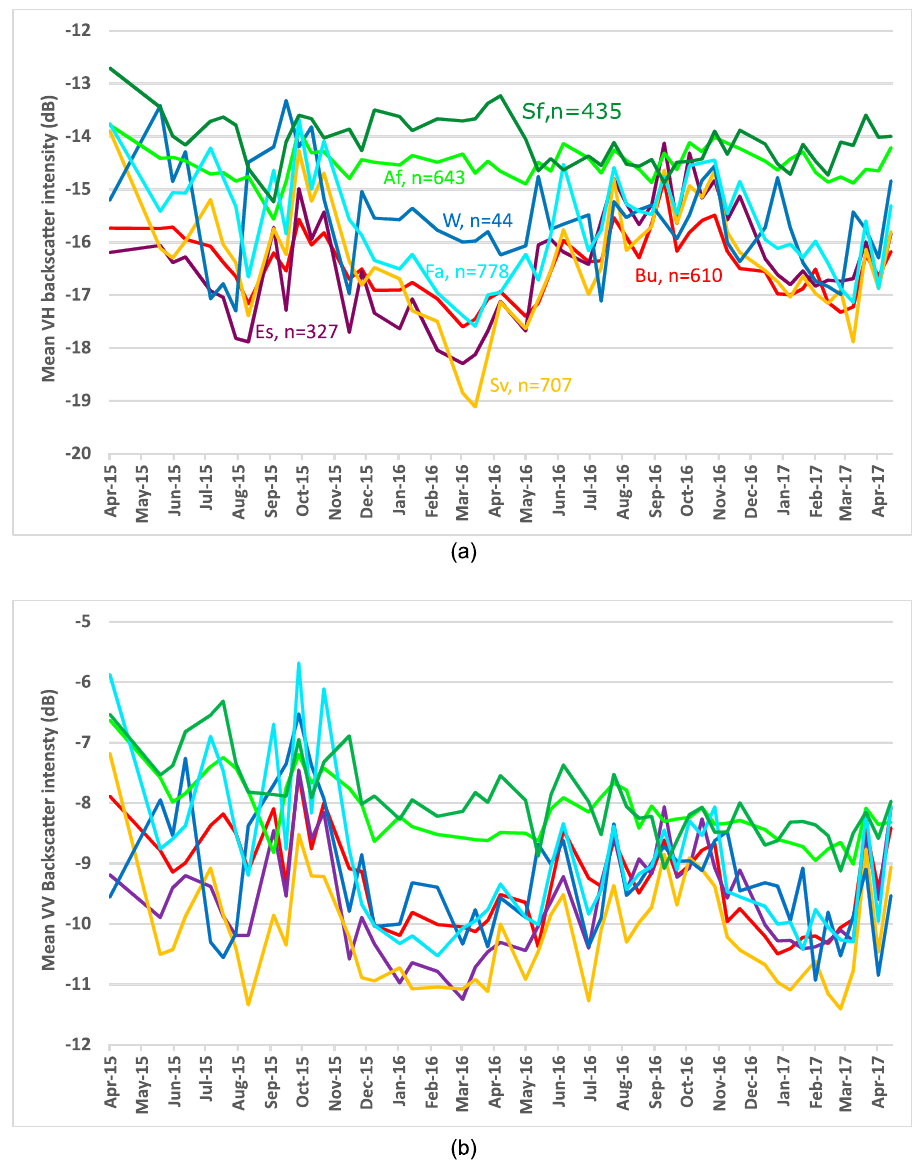
Figure 3. The radar backscatter intensity temporal profiles for the different land use/cover types using the SAR images: ( a ) vertical transmitted, horizontal received backscatter; and ( b ) vertical transmitted, vertical received backscatter. For each label, n refers to the number of sample pixels (10 × 10 m 2 ).